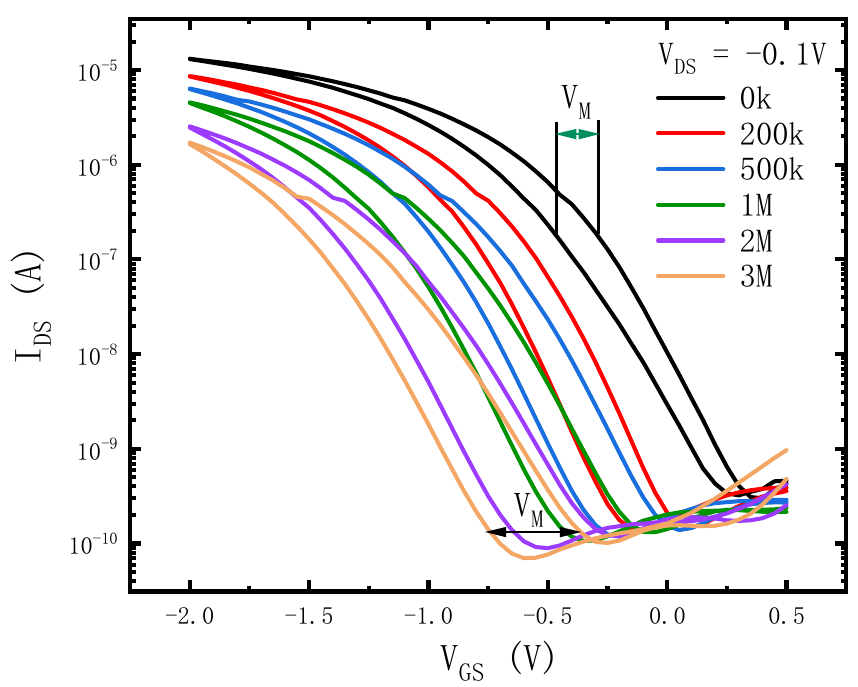
Figure 9. Hysteresis characteristics as a function of TID.